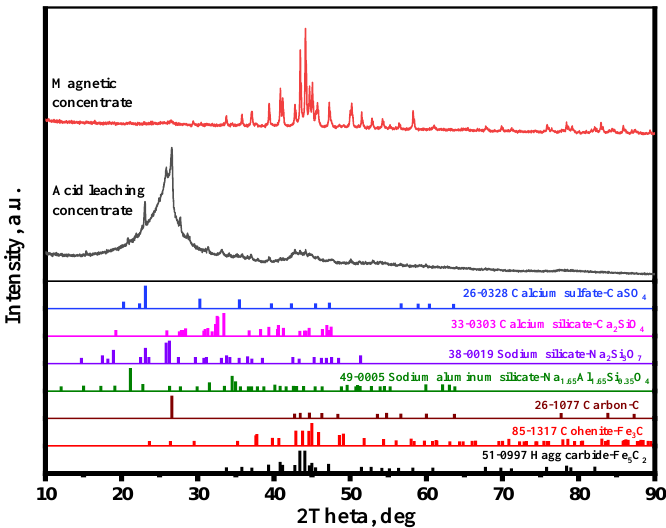
Figure 14. XRD patterns of the magnetic concentrate and acid leaching concentrate.